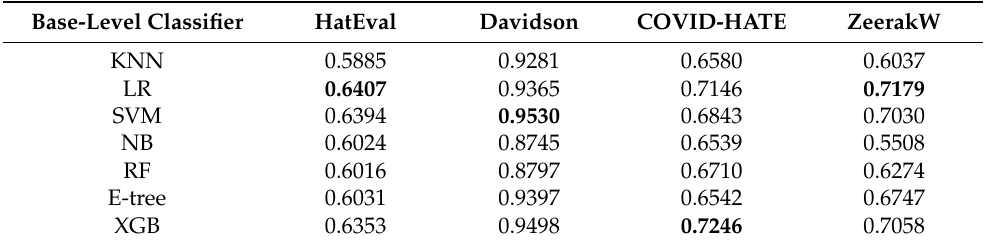
Table 8. F1-score of the Base-Level classifiers on the test set. Bold entries show the highest perfor- mance for each classifier on each